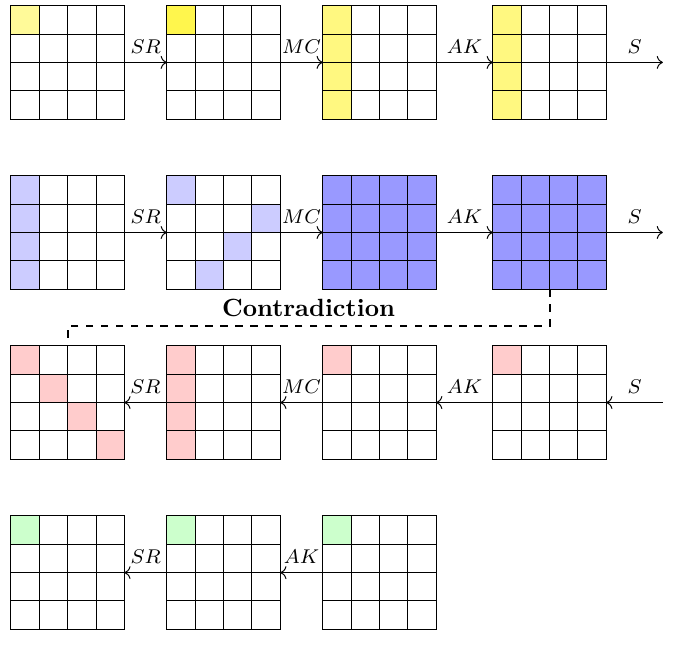
Figure 6: 4-Round Impossible Distinguisher for